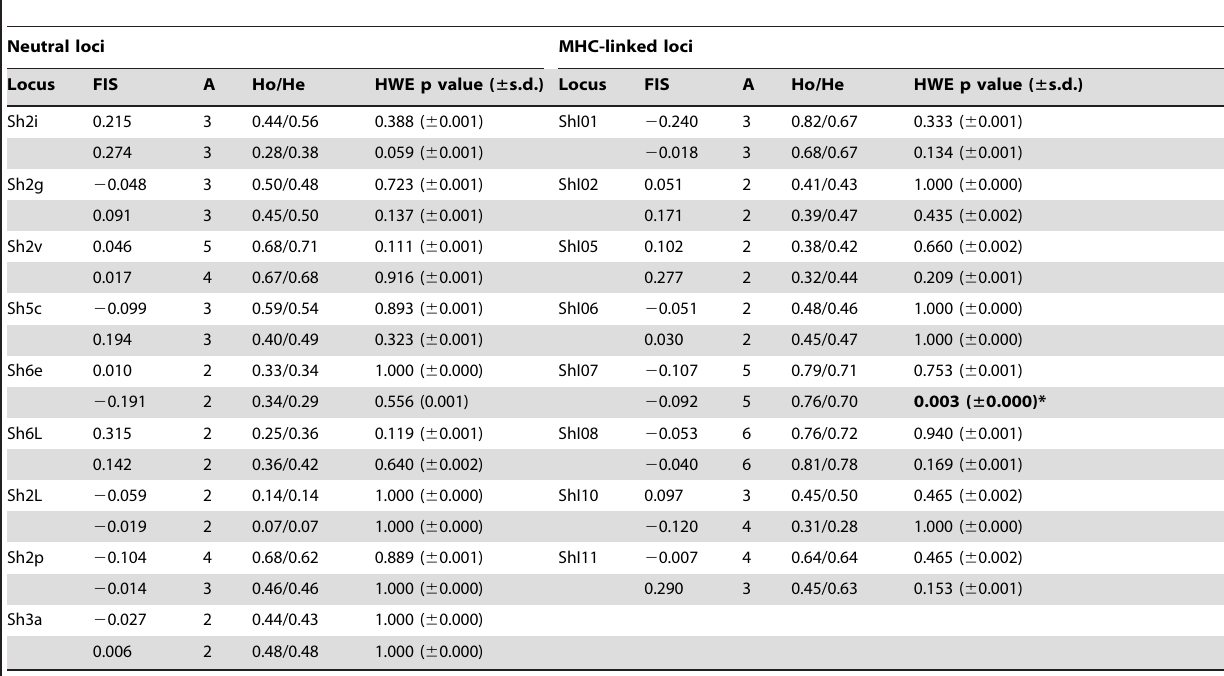
Table 2. Neutral and MHC-linked microsatellite loci summary statistics for diseased (shaded rows) and healthy devils.